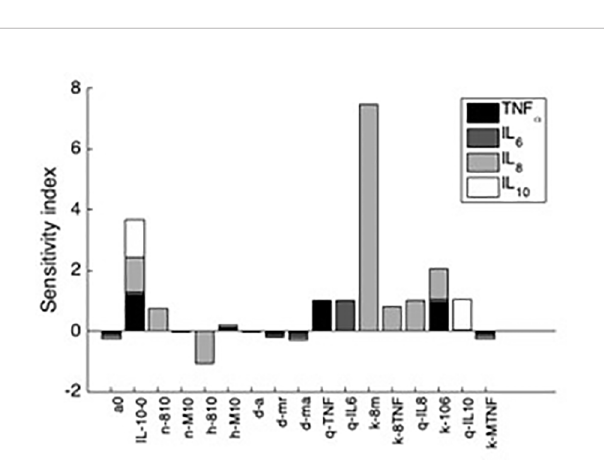
FIGURE 7 | Sensitivity indices denoting the most in fl uential parameters to each cytokine after 24h simulation. Shown are the fi rst 10 parameters that in fl uence at least a 10% change in the resulting value of at least one of the four analyzed variables. Negative sensitivity indexes indicate reduced cytokine output while the omitted parameters trivially affected cytokine